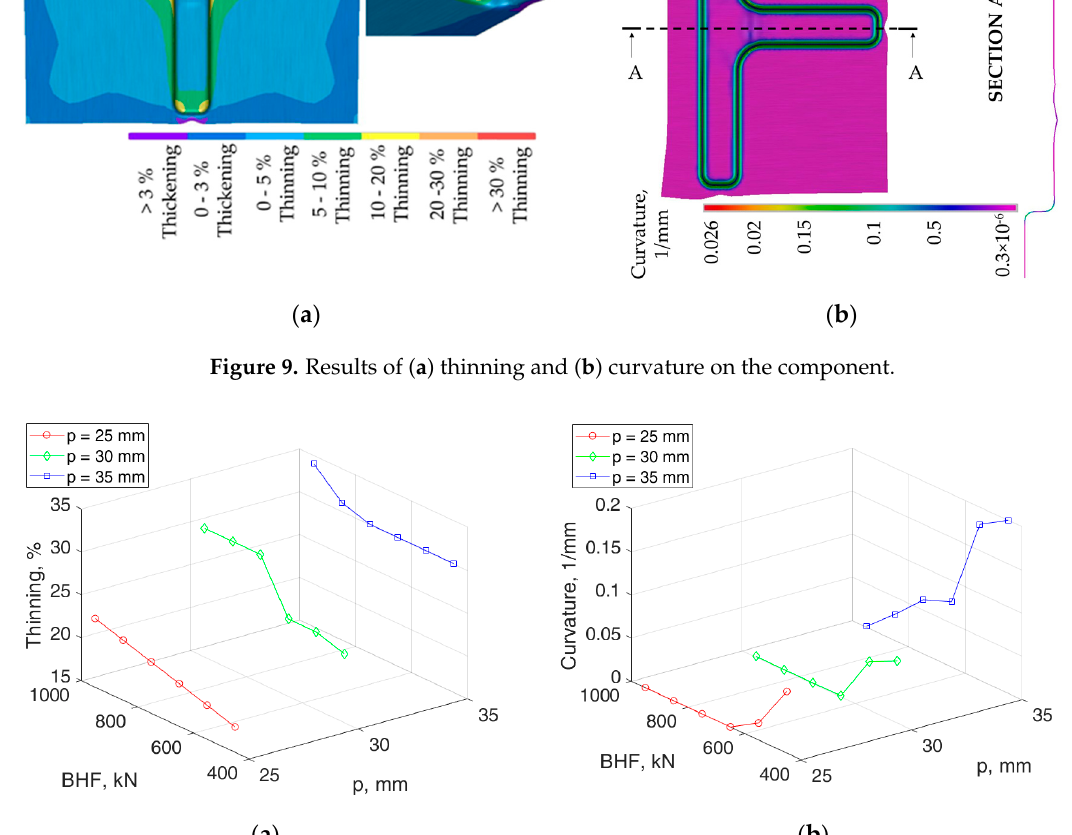
Figure 9. Results of ( a ) thinning and ( b ) curvature on the component.